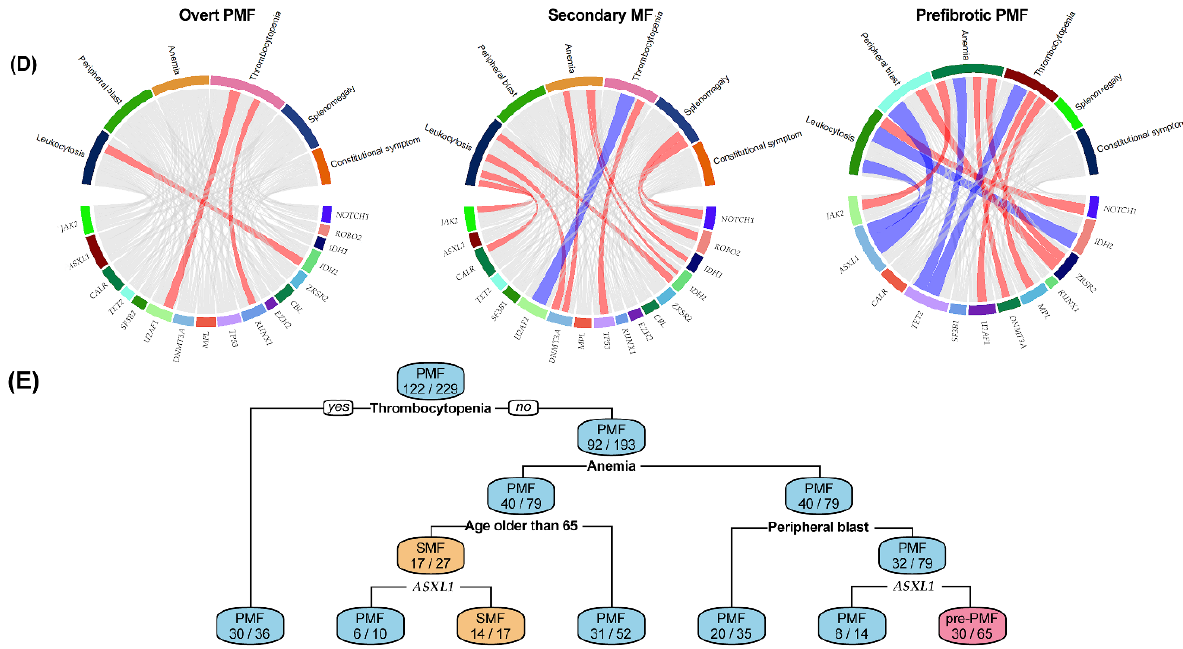
Figure 1. Mutational spectrum in overt primary myelofibrosis (PMF), secondary myelofibrosis (SMF), and prefibrotic myelofibrosis (pre-PMF). ( A ) Distribution of mutations according to the MIPSS karyotype and RNA splicing genes: SF3B1, SRSF2, ZRSR2, and U2AF1. ( B ) Proportion of genetic mutations. ( C ) Proportion of variant allele frequencies (VAF). ( D ) Chord diagram showing the correlation between clinical variables and mutations. The red bar indicates a positive correlation, and the blue bar indicates a negative correlation. The red and blue bars indicate positive and negative correlations, respectively. ( E ) Decision tree classifying myelofibrosis (MF) by clinical and mutational